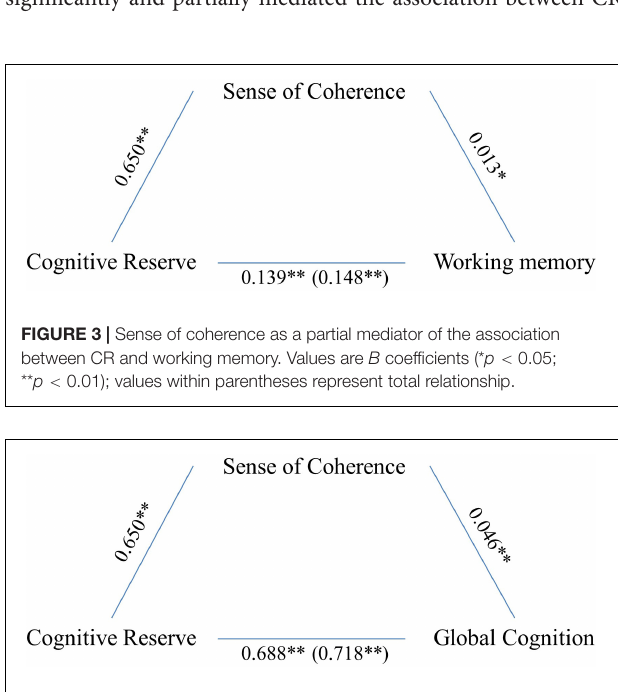
FIGURE 4 | Sense of coherence as a partial mediator of the association between CR and global cognition. Values are B coefficients (* p < 0.05; ** p < 0.01); values within parentheses represent total